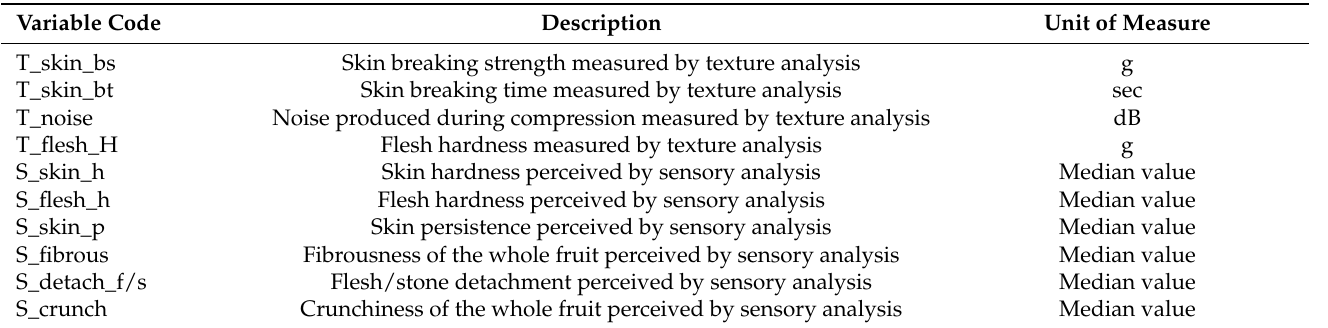
Table 2. Description of the